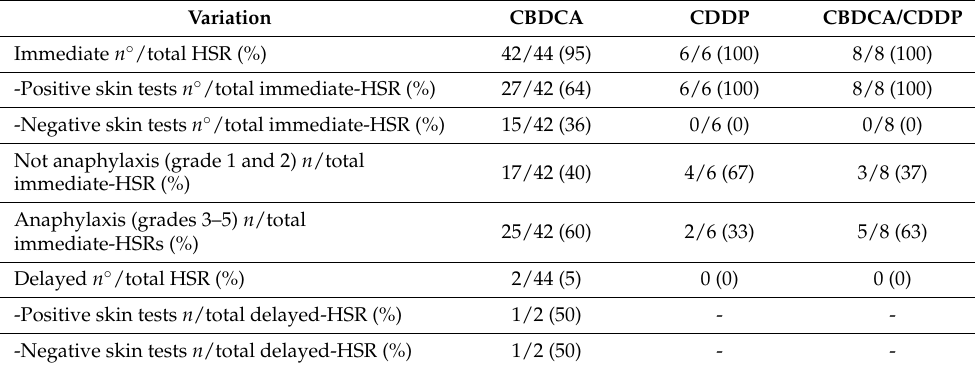
Table 2. Characteristics of HSRs to platinum agents and skin test